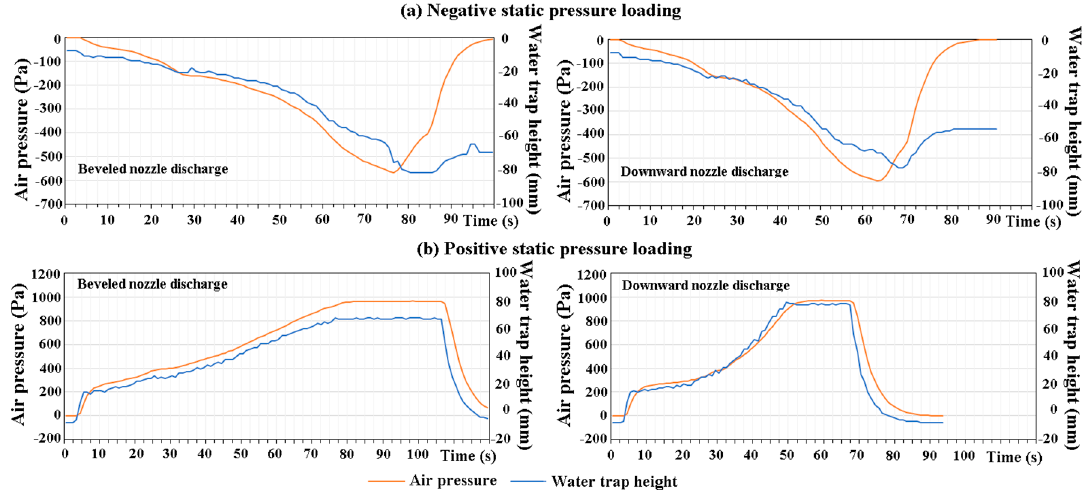
Figure 12. Temporal variations of air pressure and water trap height at: ( a ) positive; and ( b ) negative pressure loadings for test gullies with beveled and downward nozzle exits. Table 3. Maximum flow rates with various entry conditions.